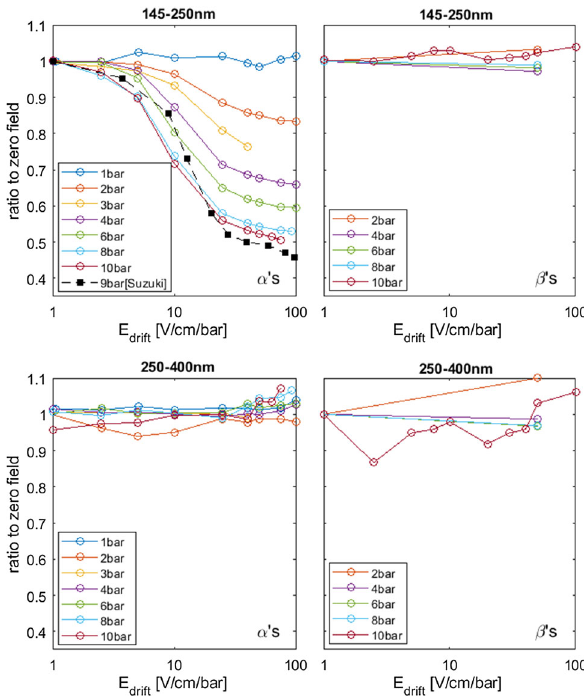
Fig. 12 Primary scintillation as a function of electric field, relative to zero-field conditions. Top-left: α -particles from an 241 Am source, observed in the band 145–250 nm (data from [20] is shown as black squares). Top-right: β -particles from a 90 Sr source, band 145–250 nm. Bottom-left: α -particles from an 241 Am source, band 250–400 nm. Bottom-right: β -particles from a 90 Sr source, band 250–400 nm.